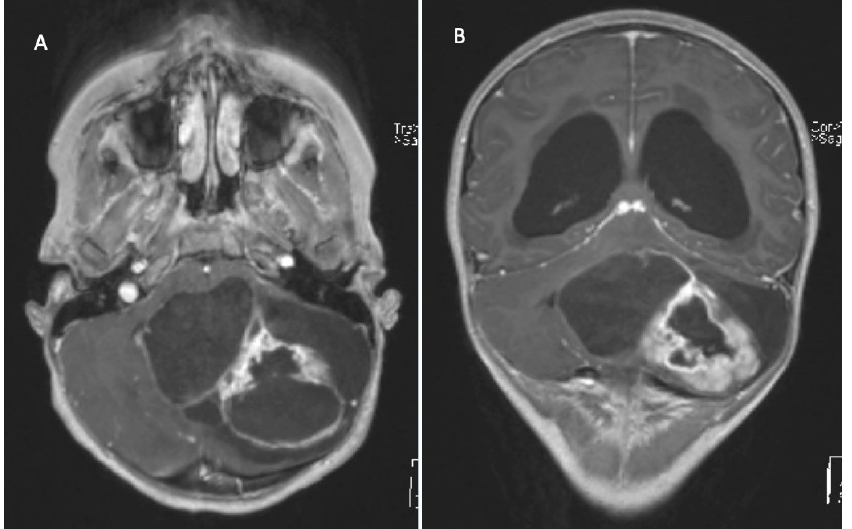
Figure 3. 12 year old girl with acute signs of raised ICP and schooling difficulties. Contrasted T1 MRI shows large cystic tumor with contrasting solid components and chronic hydrocephalus ( A , B ). Diagnosis: pilocytic astrocytoma (WHO grade 1).